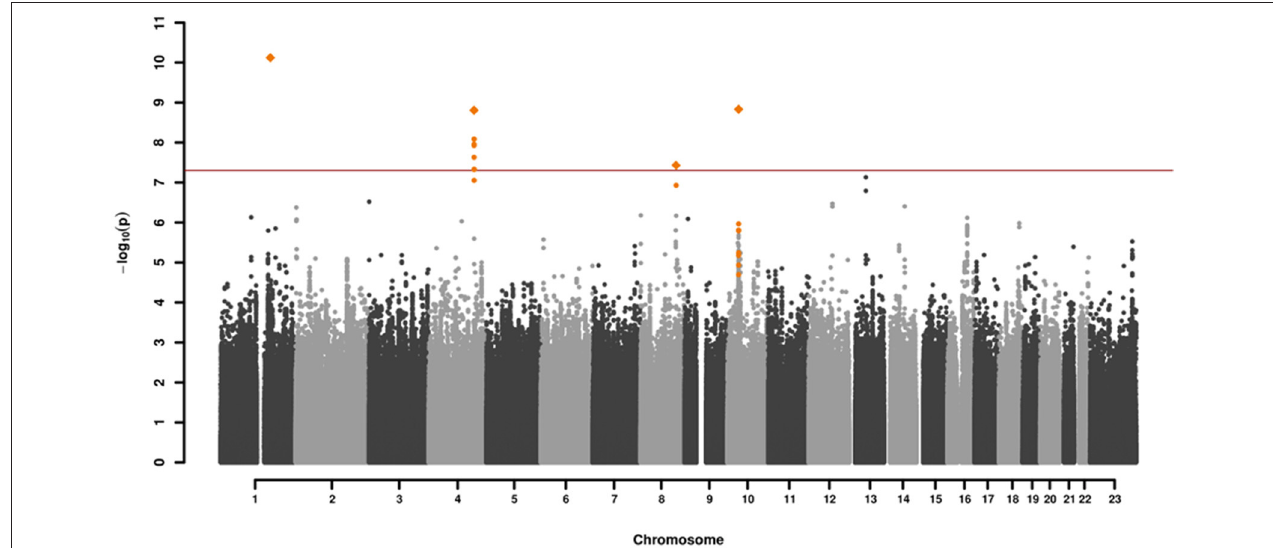
FIGURE 2 | Manhattan plot of the genome-wide association analysis of 131 cases and 2,609 controls. The x-axis shows the chromosomal position, the y-axis the significance of association [–log